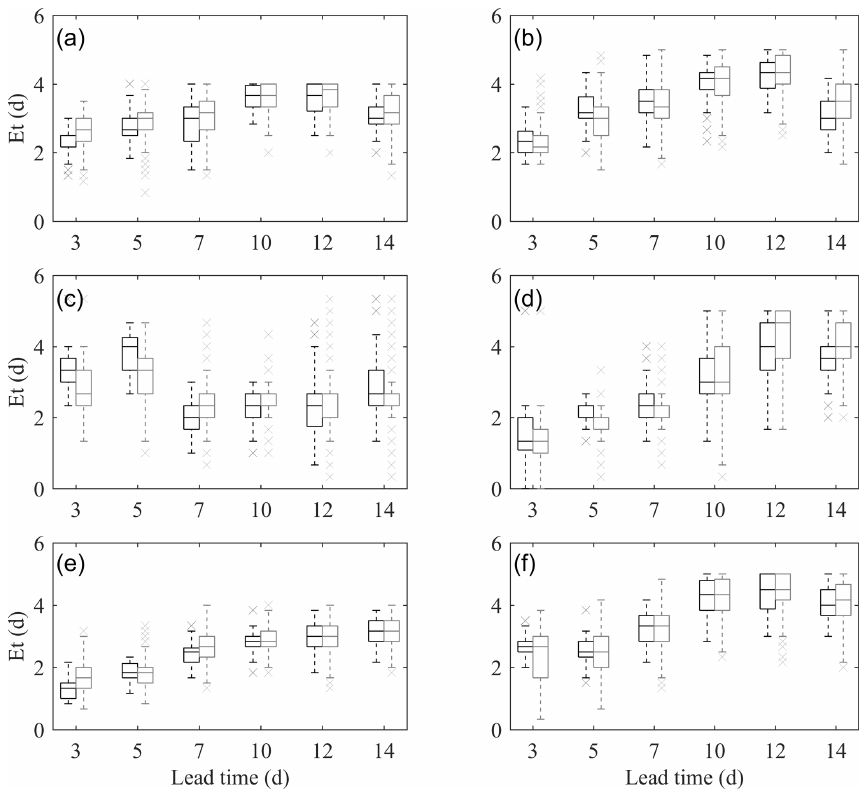
Figure 9. E t for first flood and maximum flood at (a, b) Nugesha, (c, d) Yangcun and (e, f) Nuxia. The black box plots are forecasts driven by S simulation, and forecasts derived from N simulations are denoted by